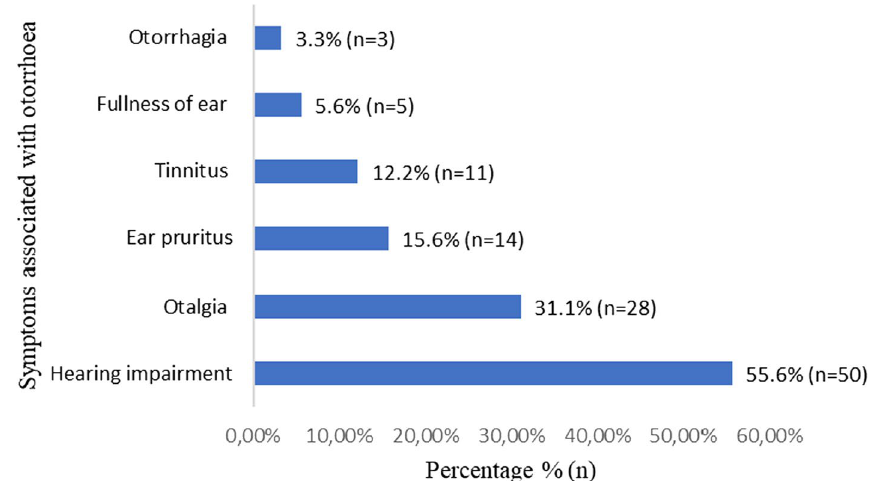
Fig. 3 The main symptoms associated with